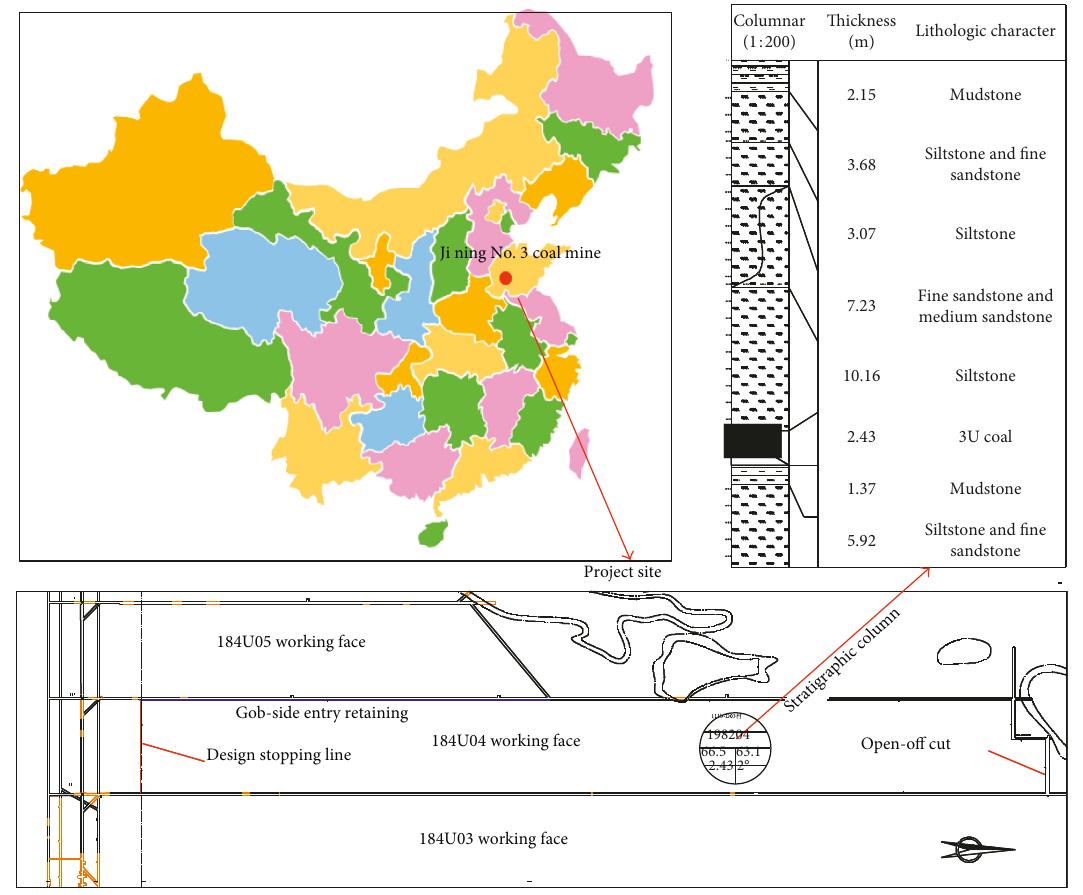
Figure 1: The engineering geological